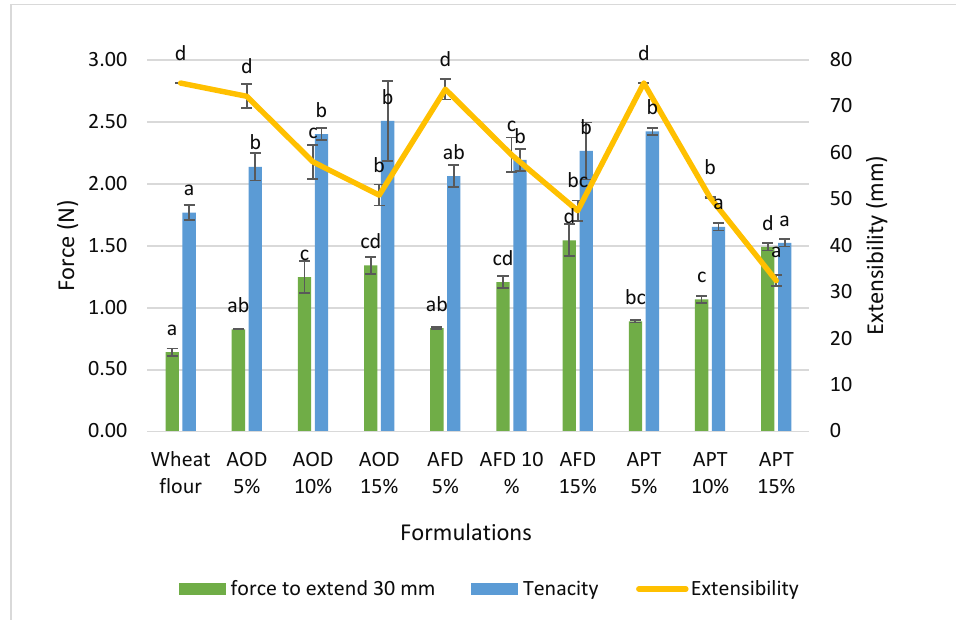
Figure 3. Effect of cricket flour on biaxial extensibility of wheat flour and cricket flour dough. Results are presented as mean of three replicates. Error bars correspond with ± standard deviations. Different letters mean statistically different values ( p < 0.05). AOD = A. domesticus oven dried; AFD = A. domesticus Freeze dried; APT = A. domesticus paste.